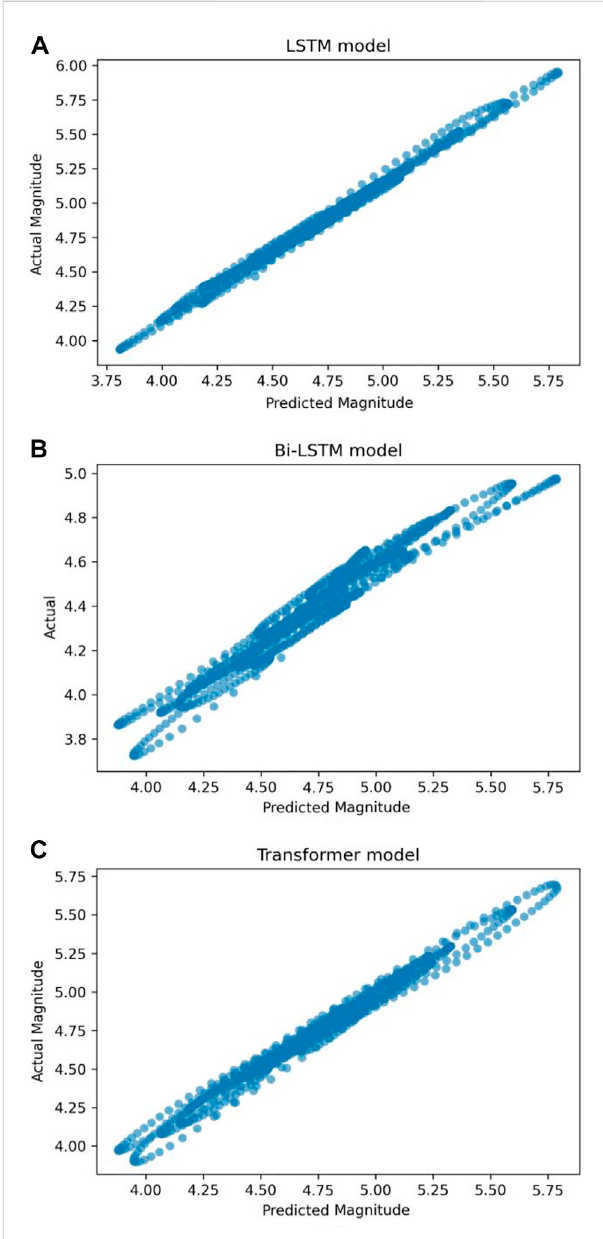
FIGURE 19 Plot of observed magnitude against anticipated magnitude utilizing (A) LSTM, (B) Bi-LSTM, and (C) transformer models on the HKKH region earthquake